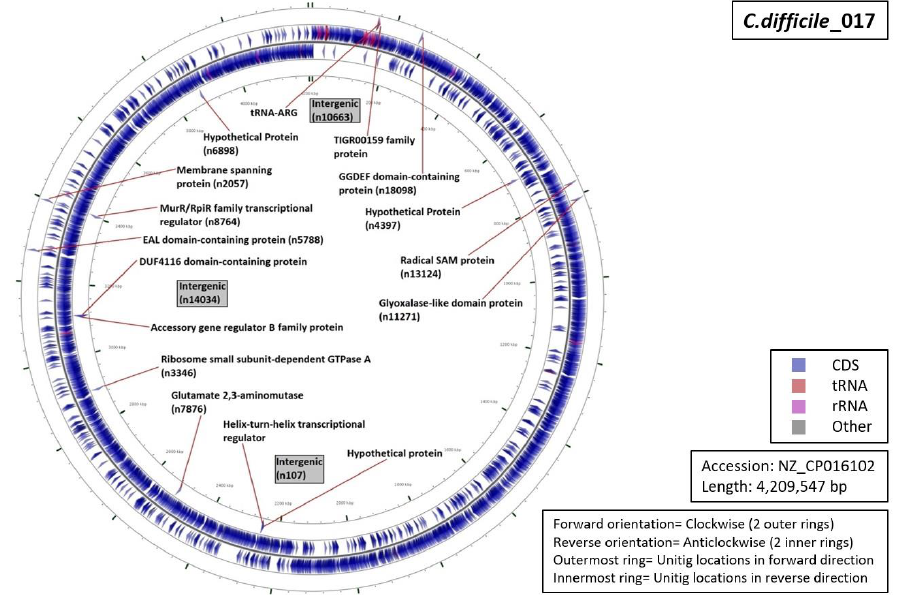
Figure 6. Functional annotation and location of DBGWAS markers on the reference genome of C. difficile RT017.